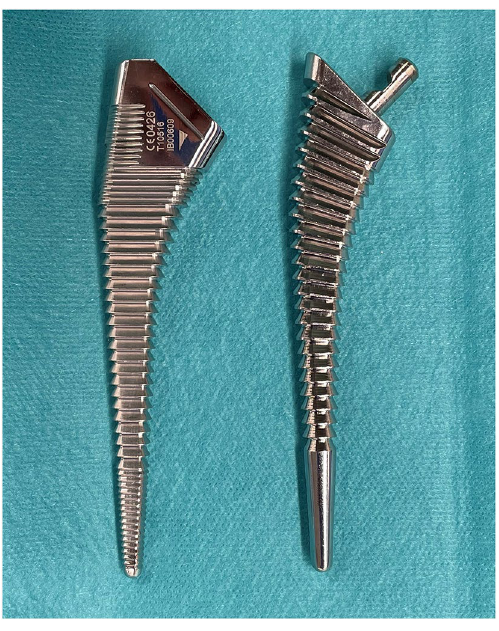
Figure 1. Antero-posterior view of each rasping broach. The broach on the left is Hydra stem and the one on the right is Corail stem. Proximal part of Hydra broach has almost no edges unlike Corail broach.